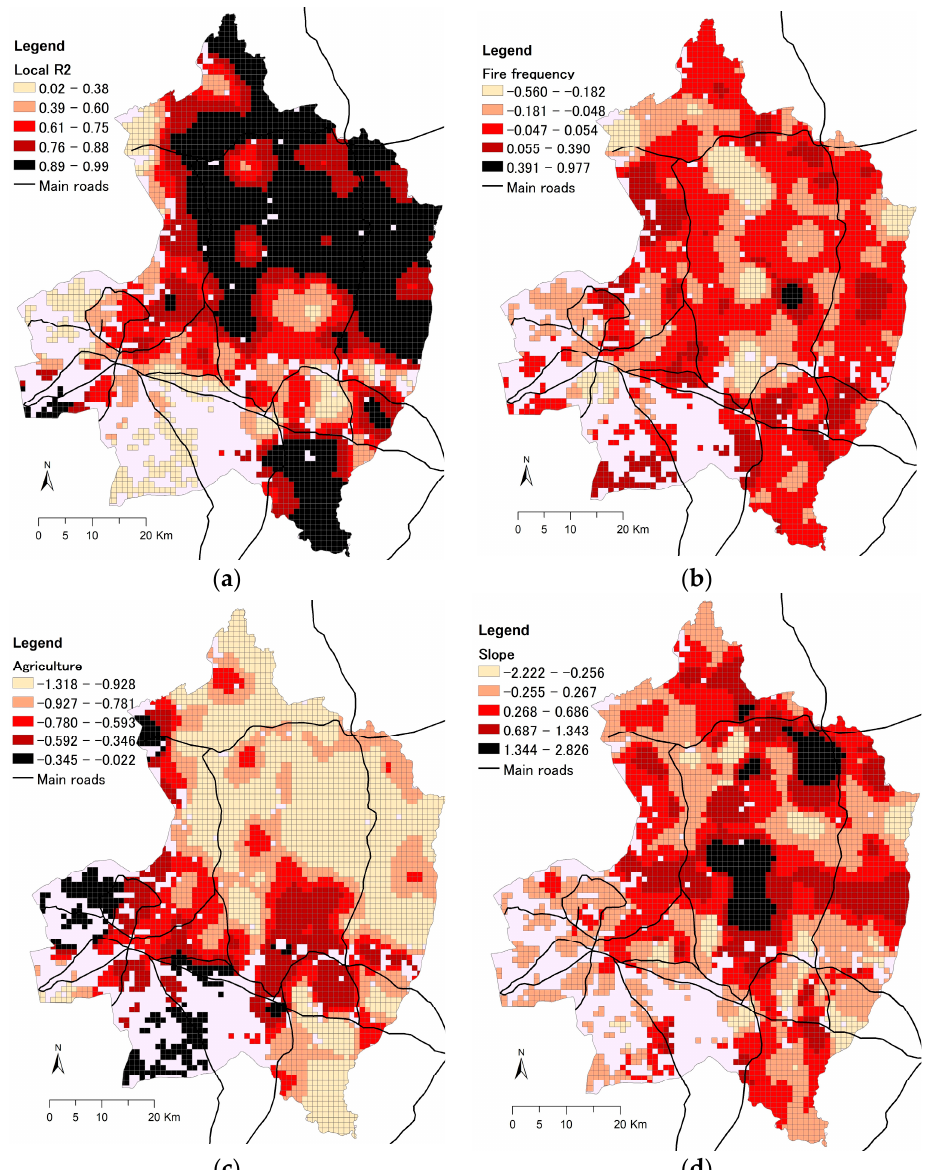
Figure 6. Spatial mapping of the locally weighed coefficient of determination ( R 2 ): ( a ), fire frequency ( b ), agriculture ( c ), slope ( d ), GWR modeling for open miombo. The more intense the brown color, the stronger the correlation. The cell sizes are 1000 × 1000 m.